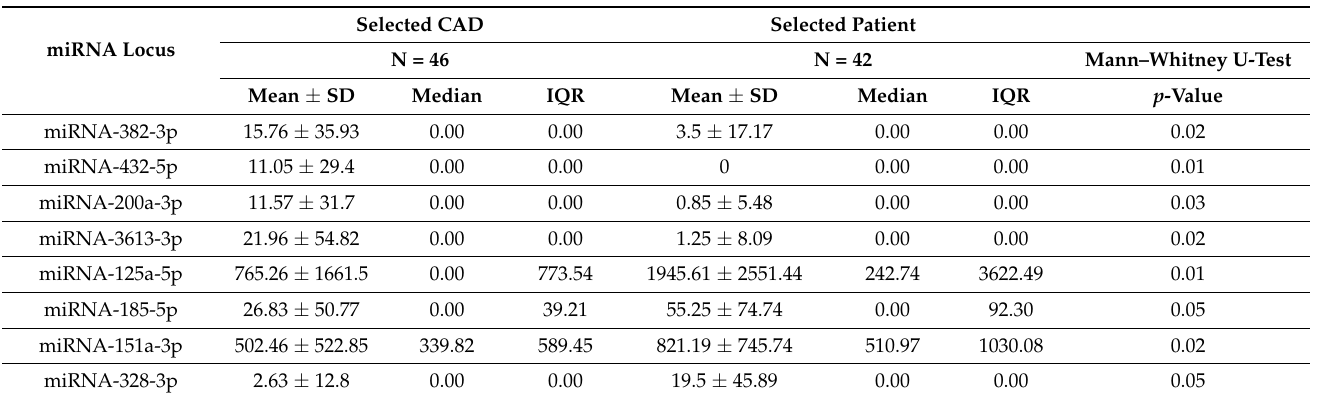
Table 4. Comparison of exosomal miRNAs from the selected CAD and patient groups. Selected CAD Selected miRNA Locus